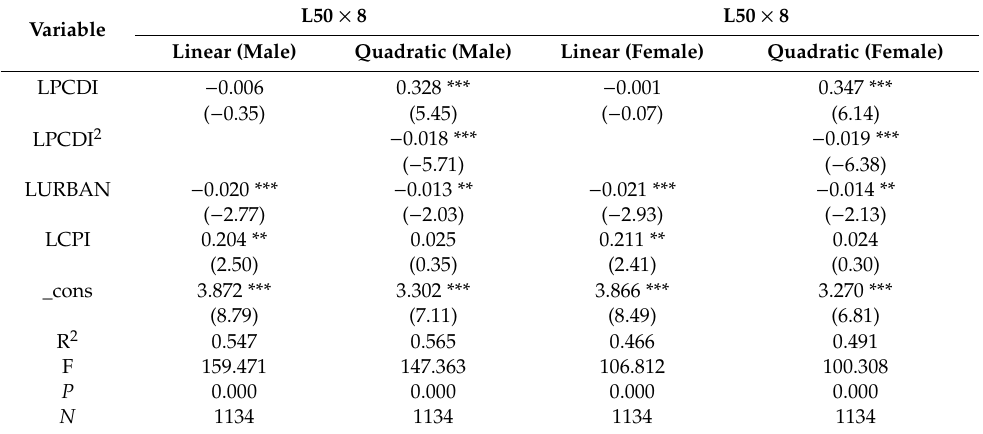
Table 4. Econometric Estimates of the Relationship Between PCDI and CRF of Children.